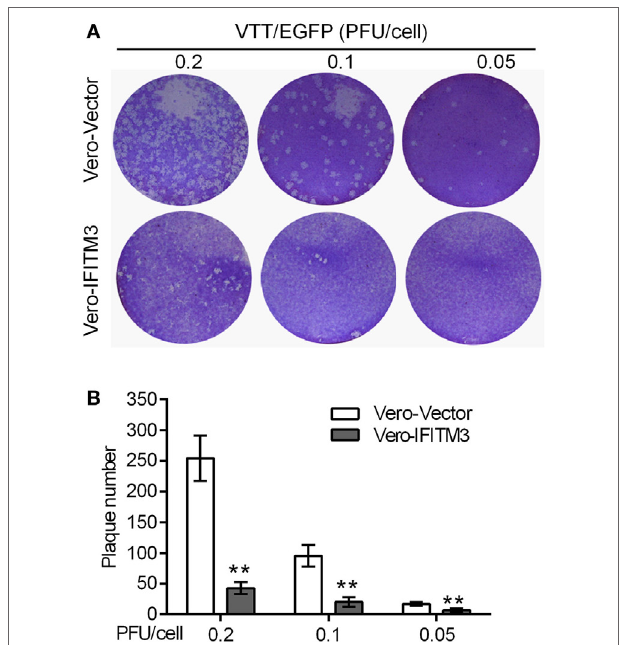
FigUre 4 | Inhibitory role of interferon-inducible transmembrane protein 3 (IFITM3) on virus cell-to-cell transmission and diffusion. Plaque formation analysis of VACV Tian Tan in Vero-IFITM3 cells at the indicated MOI was performed by crystal violet staining at 48 h postinfection (a) , and results are shown as averages of three independent experiments (B) . ** P <